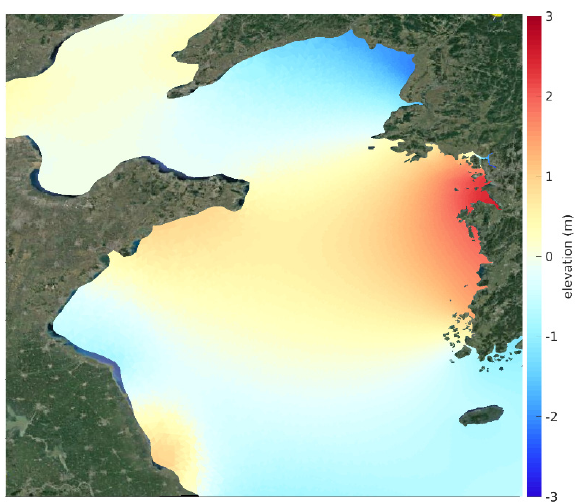
Figure 18. Tide simulation results using an ultra-high resolution grid of FVCOM-NWP.